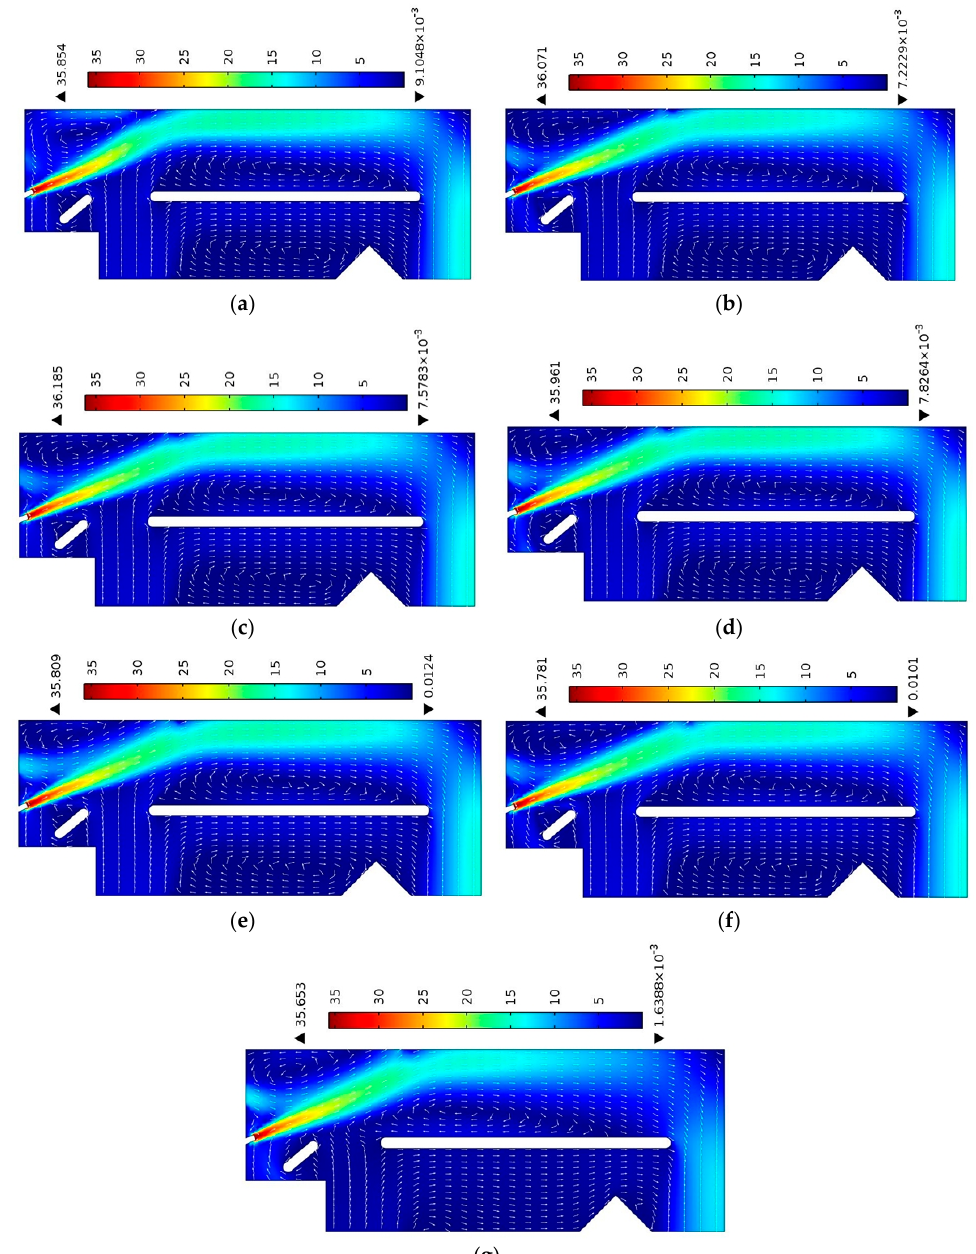
Figure 3. Contour and vector plots of velocity magnitude inside ( a ) basic, ( b ) +2 D , ( c ) +4 D , ( d ) − 2 D , ( e ) − 4 D , ( f ) − 6 D , and ( g ) − 8 D separator models at an air inlet velocity of 35 m/s and bed slanting angle ( θ ) of 0°.